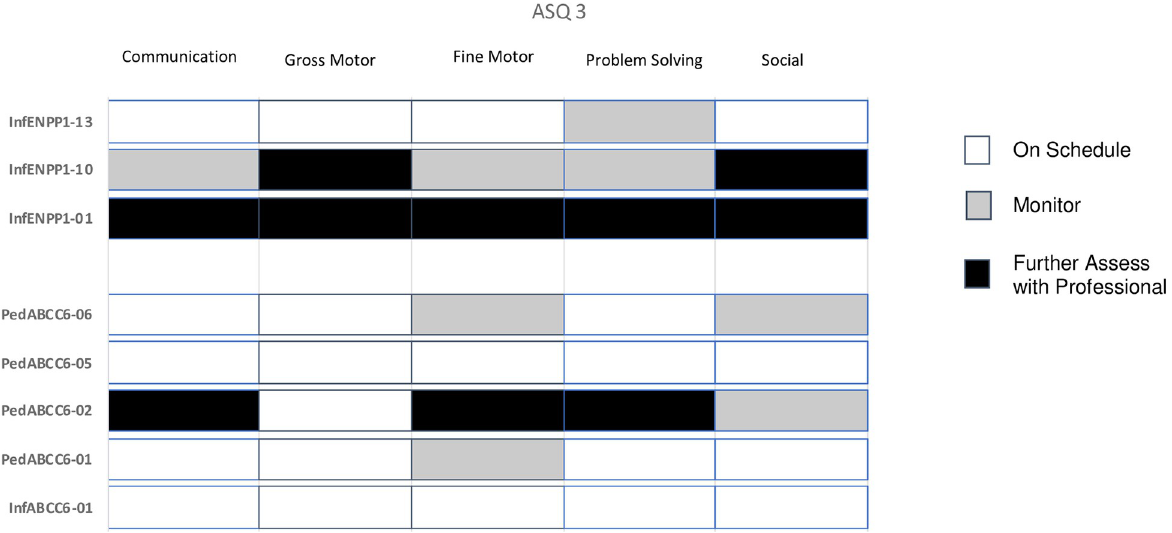
Fig 1. ASQ-3 instrument scores for infants/children with ENPP1 Deficiency/ infant onset ABCC6 Deficiency.